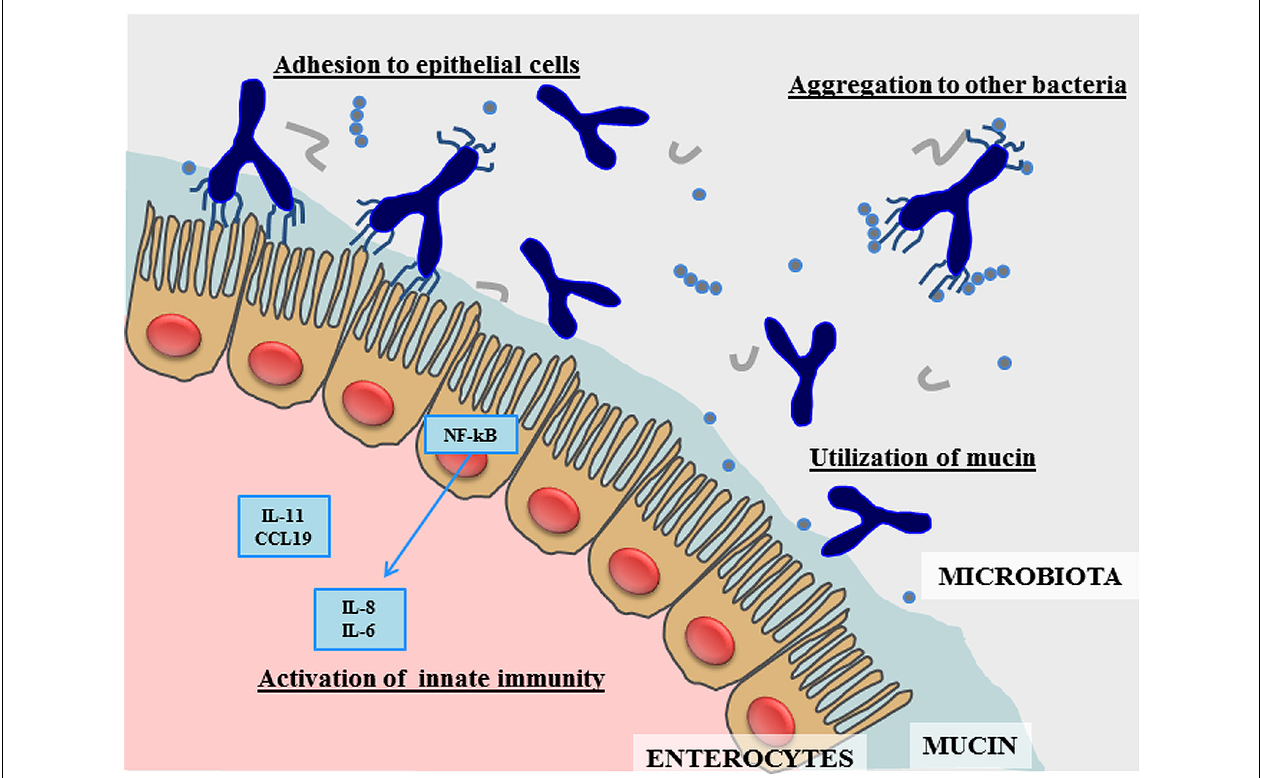
FIGURE 1 | Schematic representation of the main effects produced by Bifidobacterium bifidum in the human gut.